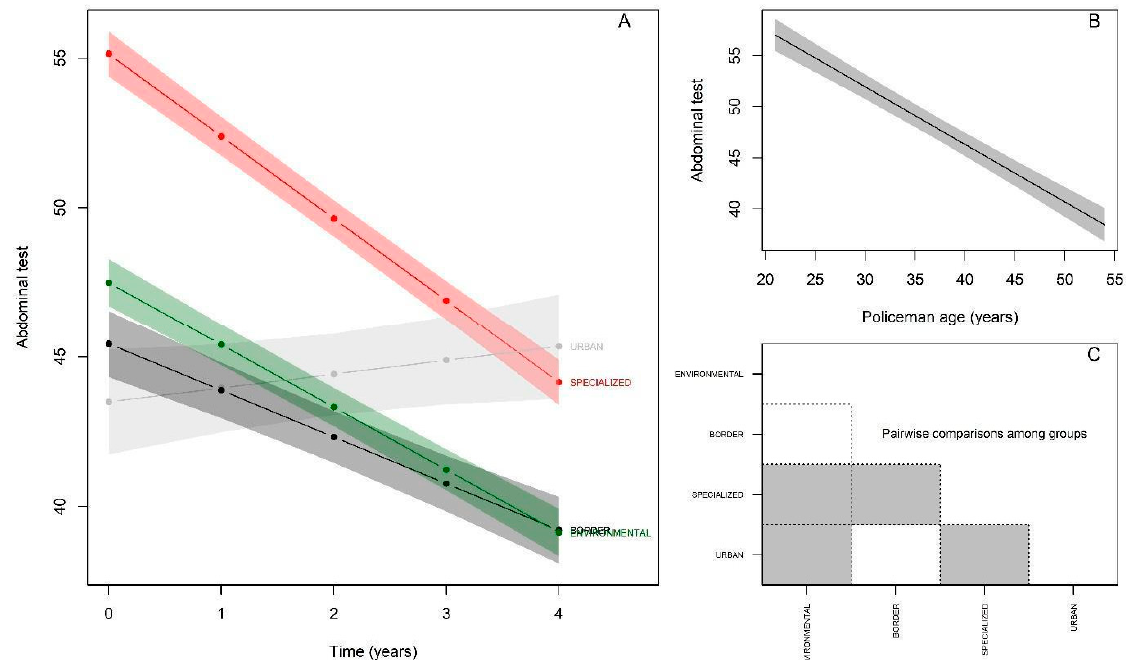
Figure 6. Performance behavior of police officers—Sit-ups Test. ( A ): Change in performance of maximum repetitions of sit-ups over 5 years according to police specialties; ( B ): Performance in maximum repetitions of sit-ups by police officers in relation to age; ( C ): Comparison of sit-up test performance between police specialties at baseline (gray color indicates significant difference between respective groups). Table 6. Statistical summary and model-estimated coefficients of the effect of group, time, and age on performance in the abdominal test.